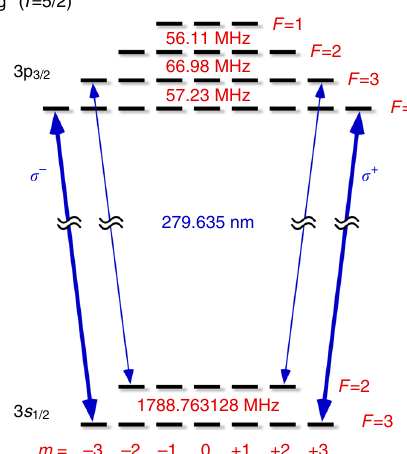
Fig. 4 The level scheme of 25 Mg + . The isotope 25 Mg + used in this demonstration has a nuclear spin of I = 5/2. The resulting hyper fi ne structure denoted by ( F , m ) is calculated using the usual A and B factors taken from 38 for the ground state ( A = − 596.254376(54) MHz) and from 39 for the excited state ( A = − 18.89 MHz, B = 22.91 MHz). The lowest lying hyper fi ne level is 745.317970(68) MHz and 65.11 MHz below the hyper fi ne centroid for the 3 s 1/2 and the 3 p 3/2 states, respectively. The cycling transitions ( thick arrows ) are driven with either σ + or σ − polarization. The F = 2 ground state, that is populated by off resonant excitation, is kept unpopulated by repumper sidebands modulated on the laser ( thin arrows spectroscopy signal is shown in Fig. 3. Assuming Poissonian the signal counts.